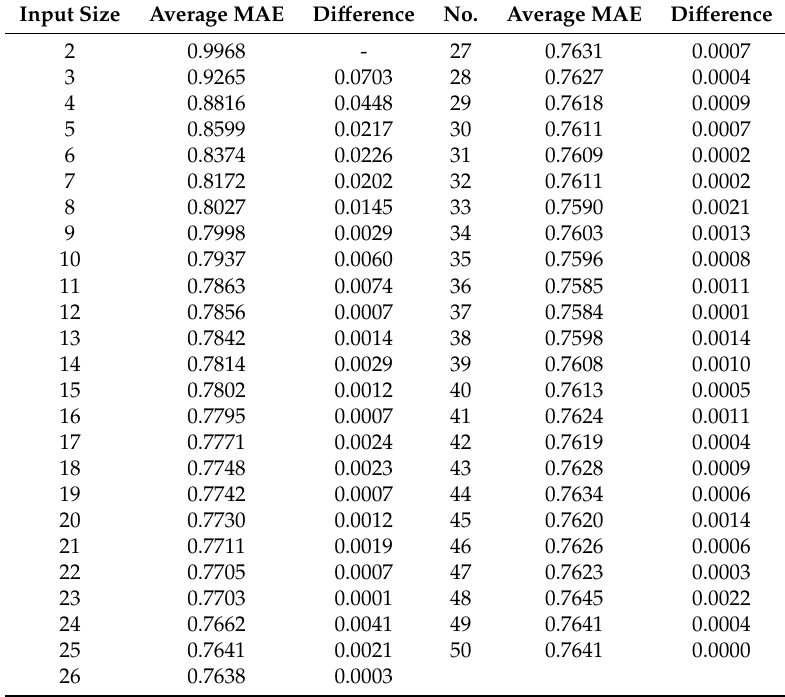
Table 13. Change in the average MAE and average di ff erence for each range (the item-based filtering: the cosine